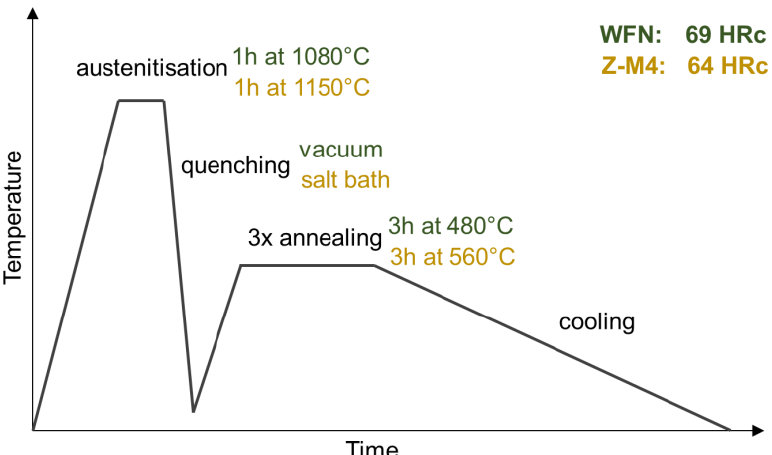
Figure 6. Thermal treatment of WFN and Z-M4 according to the data sheets [13,23].